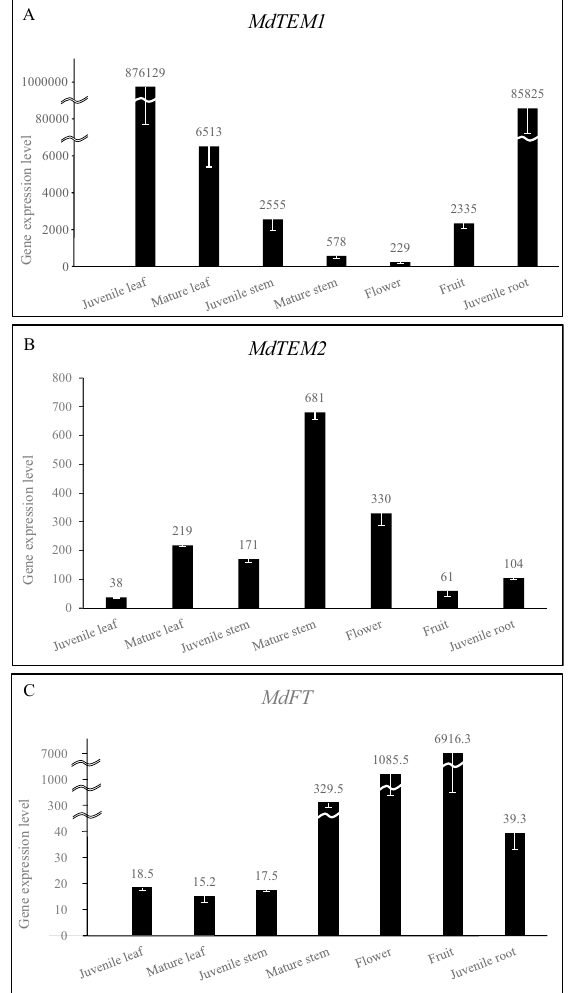
Figure 4. Expression levels of ( A ) MdTEM1 , ( B ) MdTEM2 , and ( C ) MdFT genes in different tissues in 10-year- old apple trees grown in the Khalat-Poushan Research Station of the University of Tabriz, Tabriz, Iran, at ZT 6 in the Spring of 2014 measured by qRT-PCR. The juvenile samples were taken from the seedlings grown in a growth chamber at 25 °C and 16/8 h light/dark photoperiod at ZT 6. Error bars indicate standard deviations for three technical and at least two biological